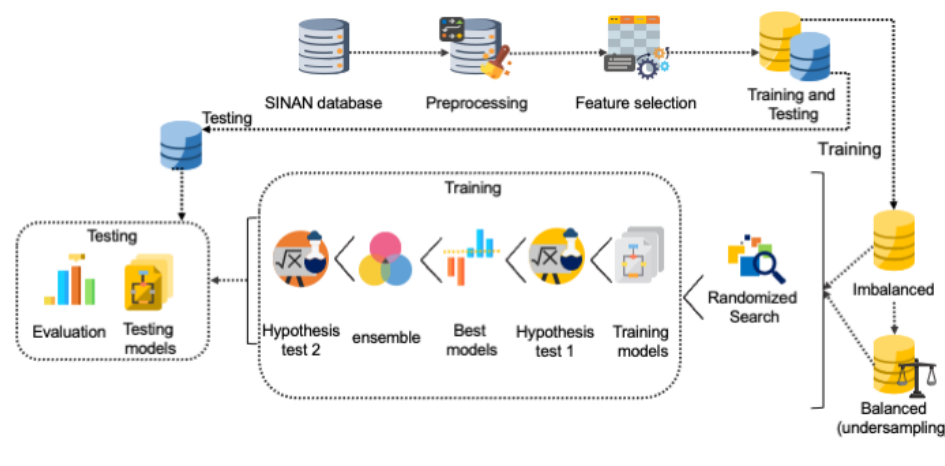
Figure 1. Methodology used to benchmark machine learning